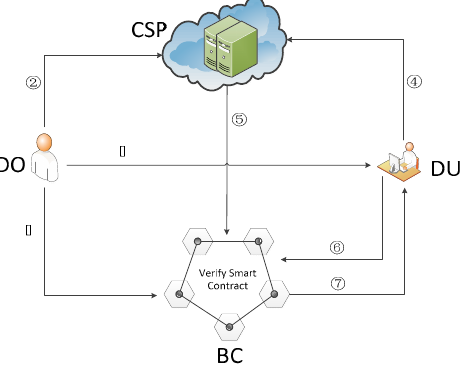
Figure 1. System model.